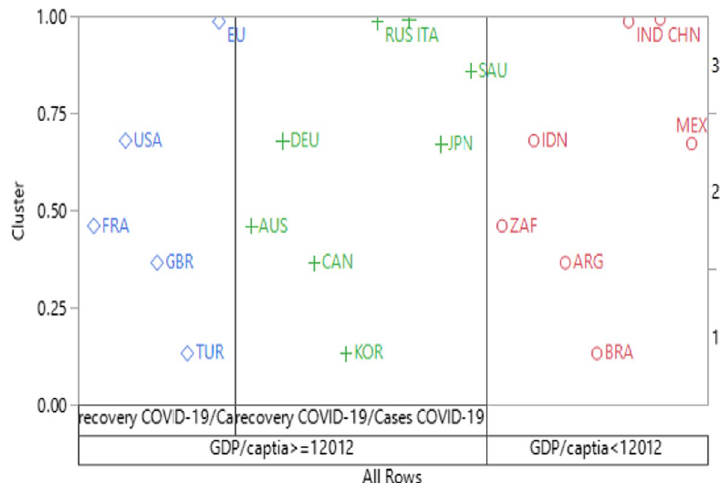
Fig. 4 Representation of clustering of G20 countries based on classification regression tree